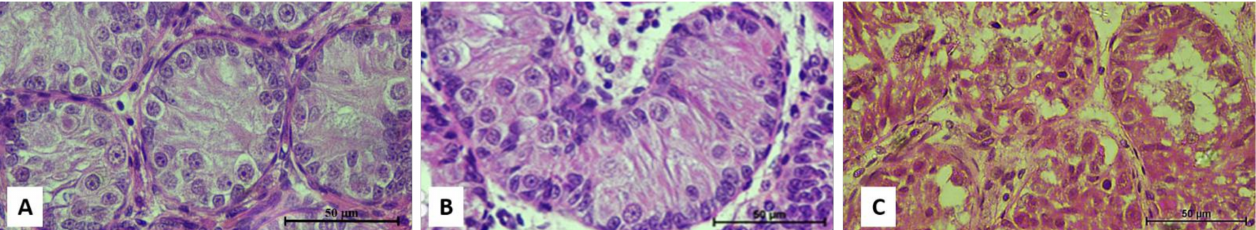
Figure 2. Photomicrograph of prepubertal cat testicular fragments. ( A ) Fresh seminiferous tubules with intact morphology; ( B ) Seminiferous tubules of testicular fragments warmed at 50 ◦ C af- ter vitrification using dimethyl sulfoxide/glycerol association, showing preserved morphology; ( C ) Seminiferous tubules of testicular fragments warmed at 60 ◦ C after vitrification using dimethyl sulfoxide/glycerol association, showing degenerate morphology. Note the stroma rupture and basement membrane detachment. H-E, 400 ×